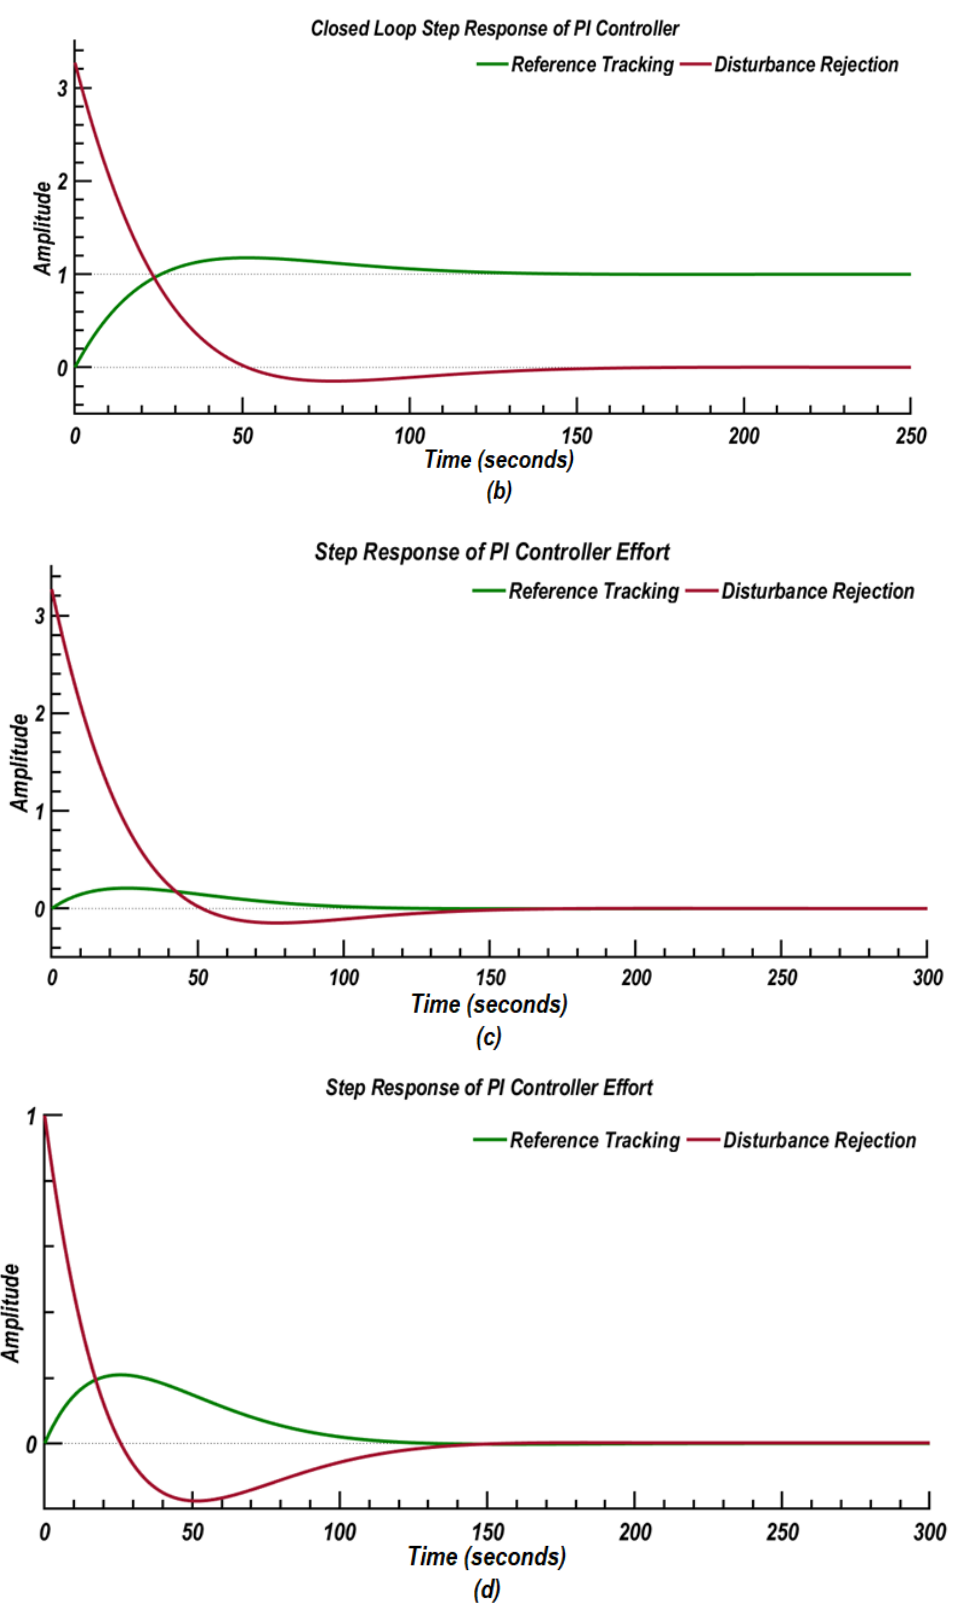
Figure 23. Step responses of the PI controller with KP = 3.27 and KI = 0.083 for reference tracking and disturbance rejection. ( a ) Open-loop step response of PI controller. ( b ) Closed-loop step response of PI controller. ( c ) Closed-loop step response in case of input disturbance ( d 1 ). ( d ) Closed-loop step response in case of output disturbance ( d 2 ).